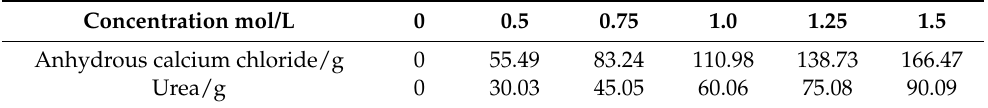
Table 3. Cementation solution configuration